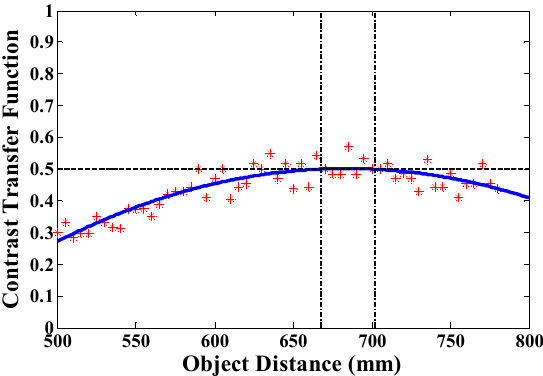
Figure 5. Measured contrast transfer function (CTF) values (dot), for the spatial target group-1/element-1, along the optical axis before and after the focal spot. X-axis is the absolute distance between the target and the front of the lens. The dashed line is the quadratically fitted curve, while the vertical dashed lines mark regions with CTF ≥ 0.5.